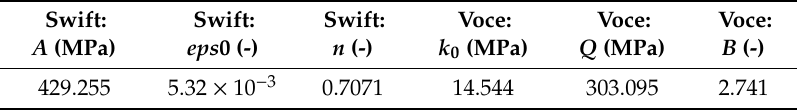
Table 1. Parameters obtained for the hardening